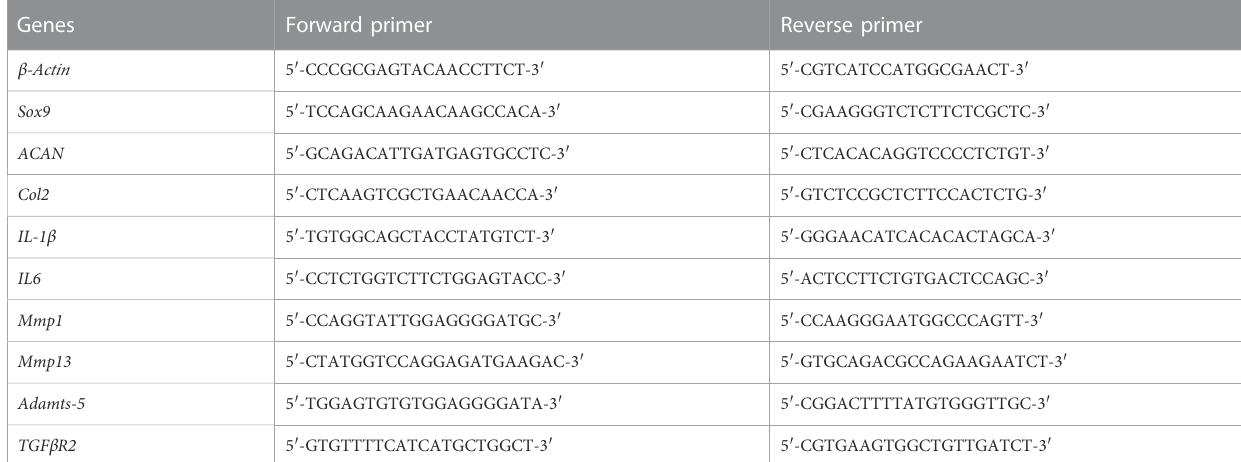
TABLE 1 Primer sequences used for qPCR